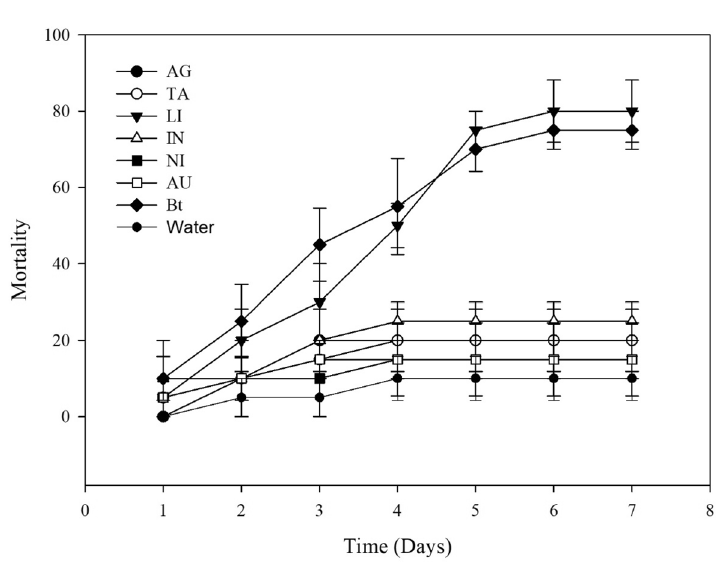
Figure 4. Cumulative mortality of Spodoptera frugiperda caused by adjuvant mixtures and Bt biopesticides in wettable powder (WP) formulation. Concentration of 10 6 spores per